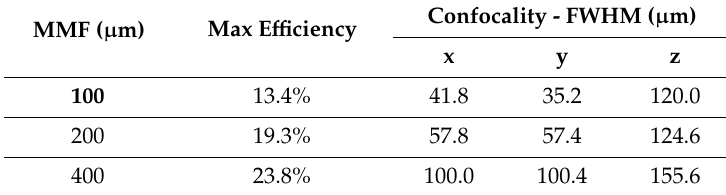
Figure 3. Confocal behavior of the system by simulation. Each subfigure shows the efficiency changes with respect to the displacement of the point source in ( a ) x ‐ , ( b ) y ‐ and ( c ) z ‐ axis, respectively. 100 μ m, 200 μ m and 400 μ m MMF are used as collection fiber. Table 1. Confocality behavior of the setup from simulations.